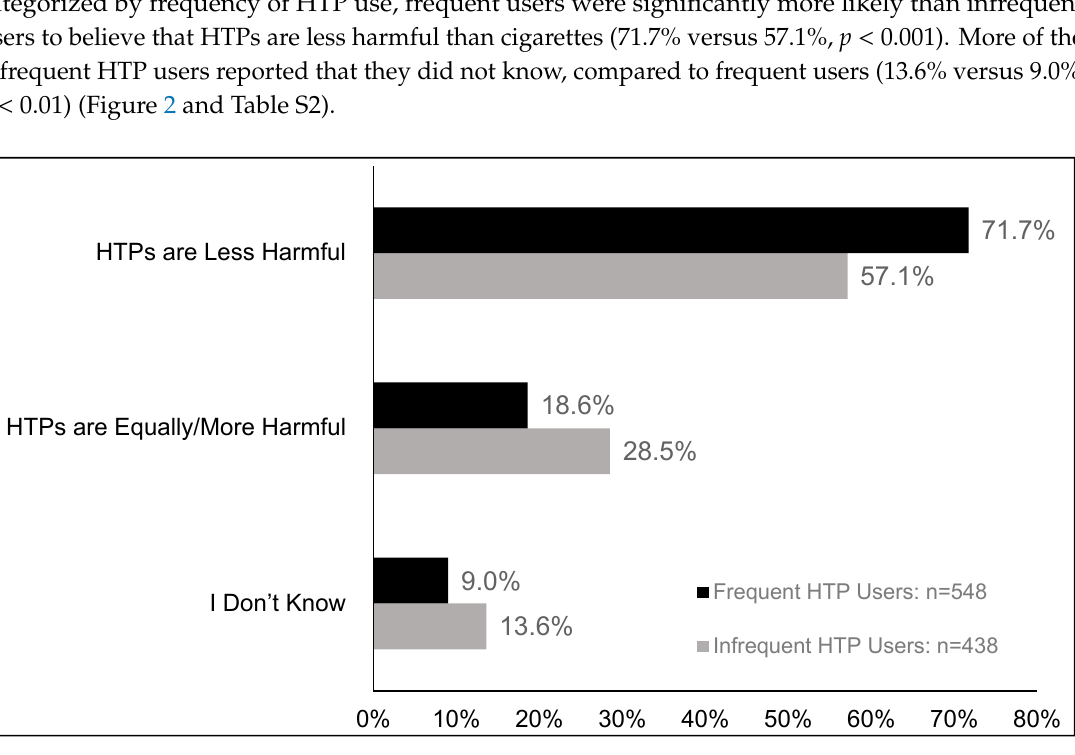
Figure 2. Relative perceptions of harmfulness of HTPs compared to cigarettes among concurrent users